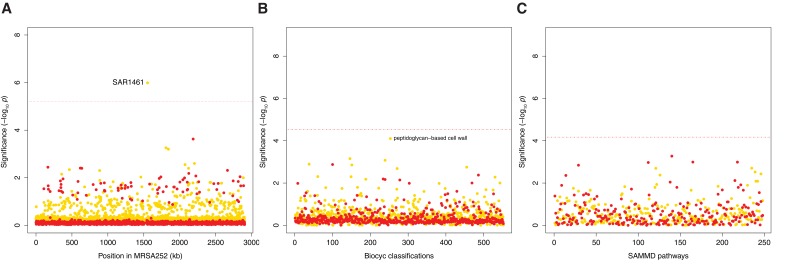
Genes, ontologies and pathways enriched for protein-altering transient variants within nose-colonizing and infection-causing bacteria.(A) Significance of enrichment of 2650 individual genes. SAR1461 encodes Pbp2, penicillin-binding protein 2. (B) Significance of enrichment of 552 gene sets defined by BioCyc gene ontologies. (C) Significance of enrichment of 248 gene sets defined by SAMMD expression pathways. C-class variants among nose-colonizing bacteria are colored gold, D-class variants among infection-causing bacteria are colored red. Genes, pathways and ontologies that approach or exceed a Bonferroni-corrected significance threshold of α = 0.05, weighted for the number of tests per category, (red lines) are named.